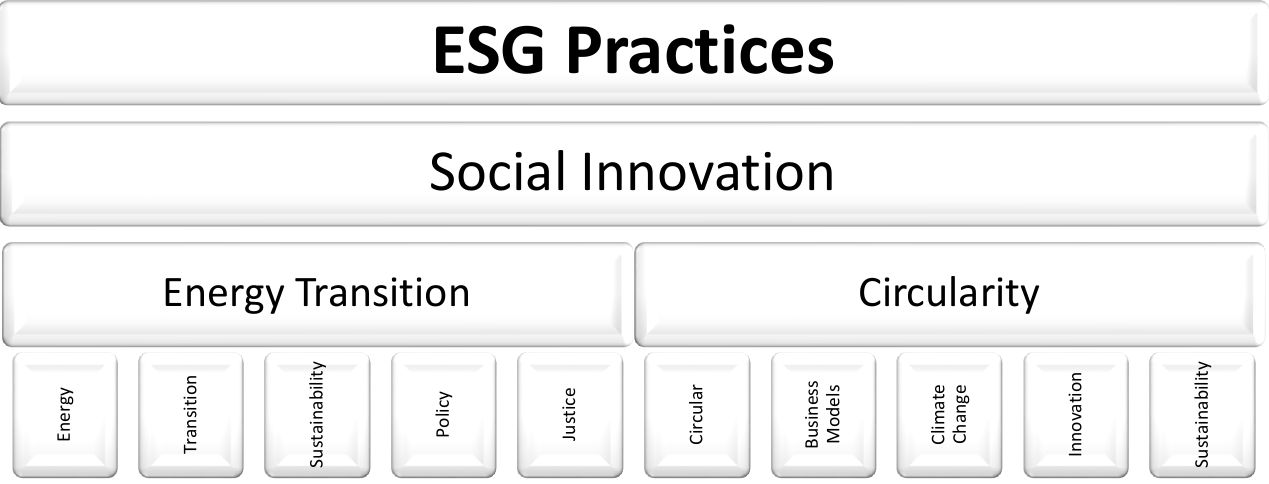
Figure 13. ESG Framework through integration of social innovation with energy transition and circularity.